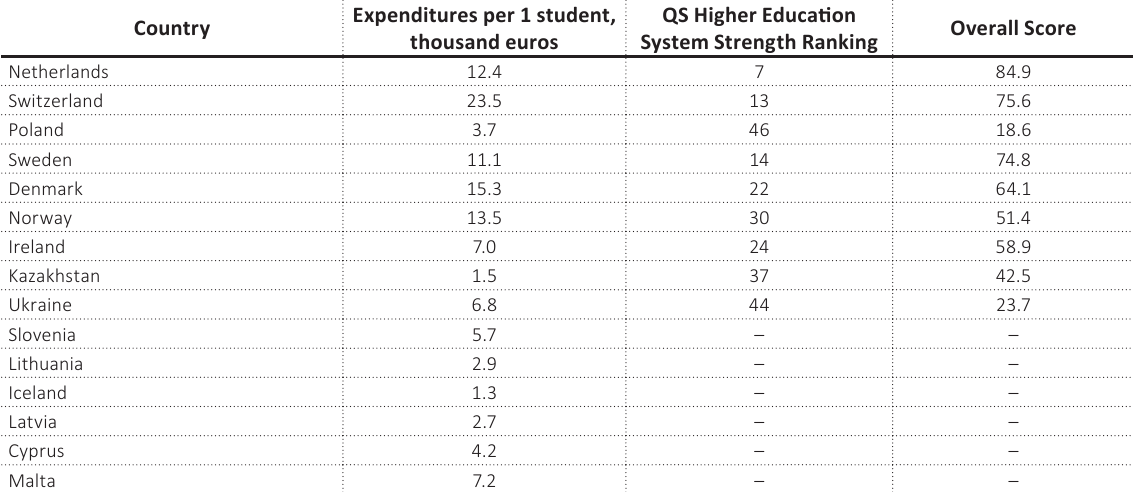
Table 3. QS Higher Education System Strength Rankings – 2018